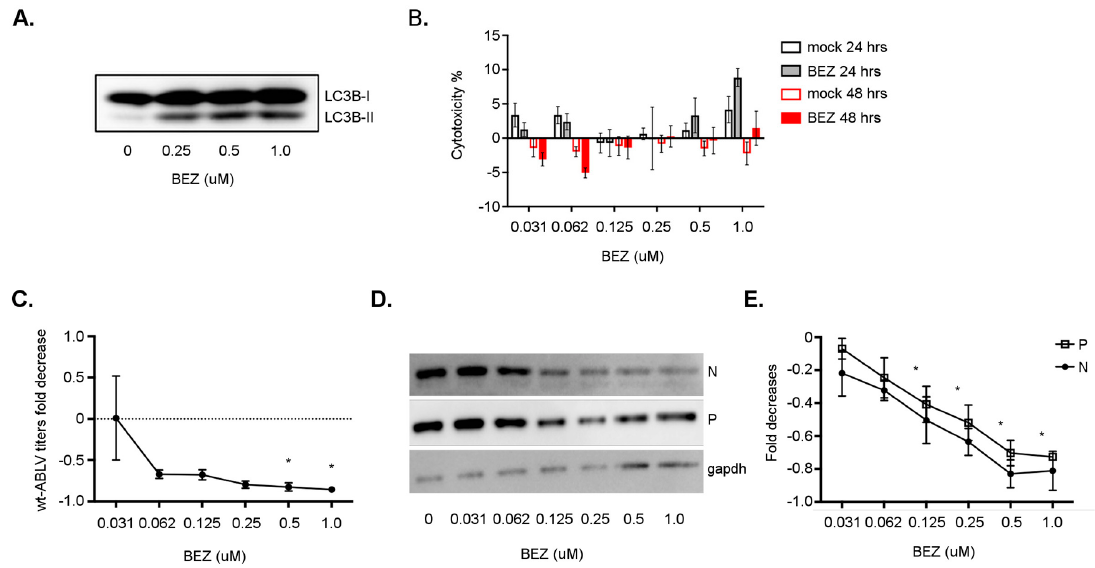
Figure 7. BEZ treatment reduced wt-ABLV replication in a human neuroblastoma cell line. ( A ) Western blot of LC3B protein in lysates from NBF-L cells were treated with indicated concentrations of BEZ